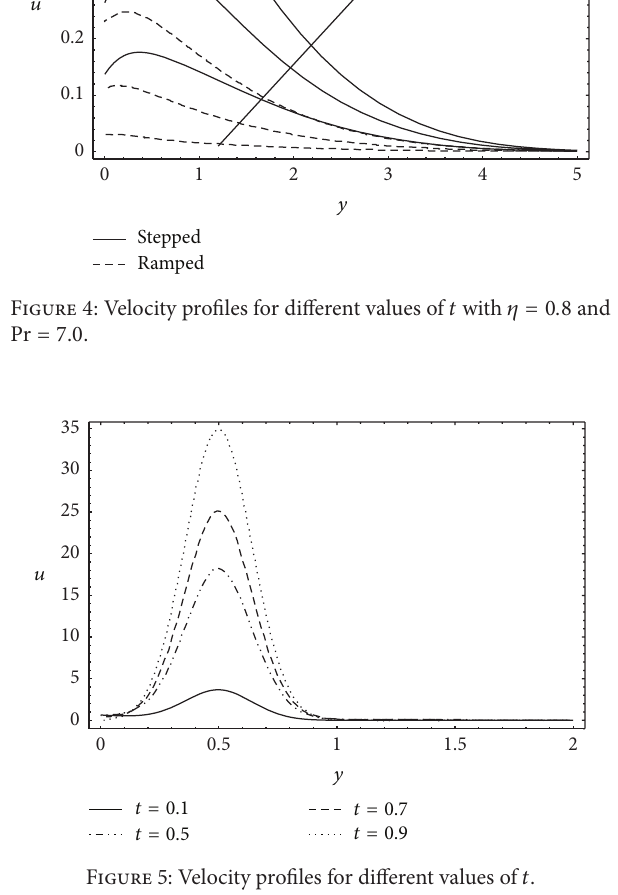
Figure 7: Temperature profiles for different values of 𝑡 .